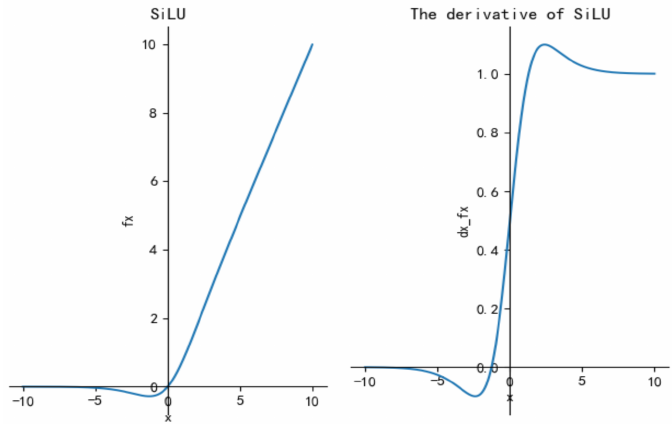
Figure 4. The activation function and derivative curves of